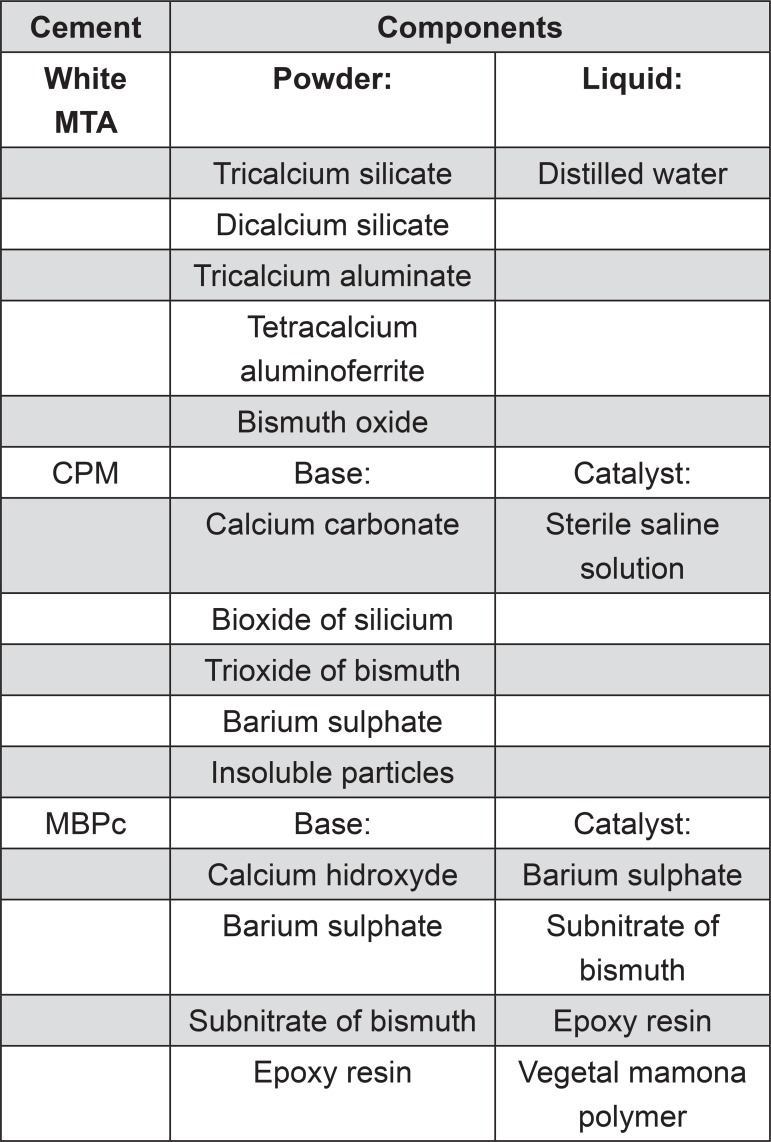
Composition of the evaluated cements